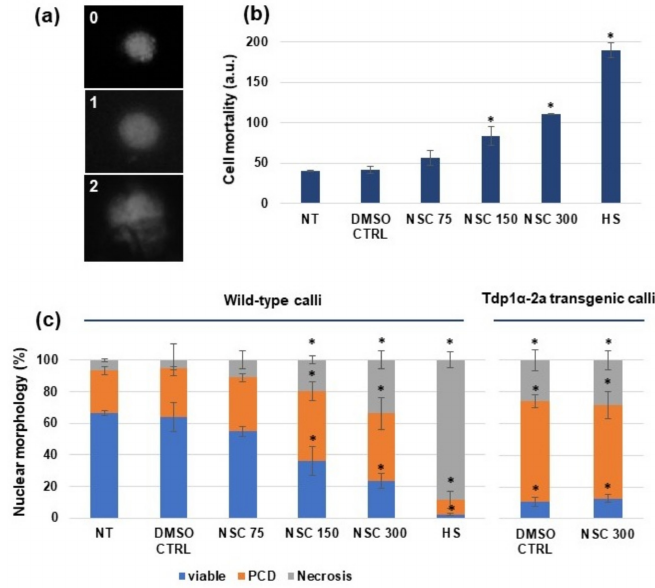
Figure 1. Cell viability in Medicago truncatula calli treated with NSC120686 as assessed by DNA diffusion assay. ( a ) Nuclear morphology of viable (0), programmed cell death (PCD) (1), and necrosis (2) events. ( b ) Cell mortality (represented in arbitrary units, a.u.) of M9-10a wild-type calli in response to